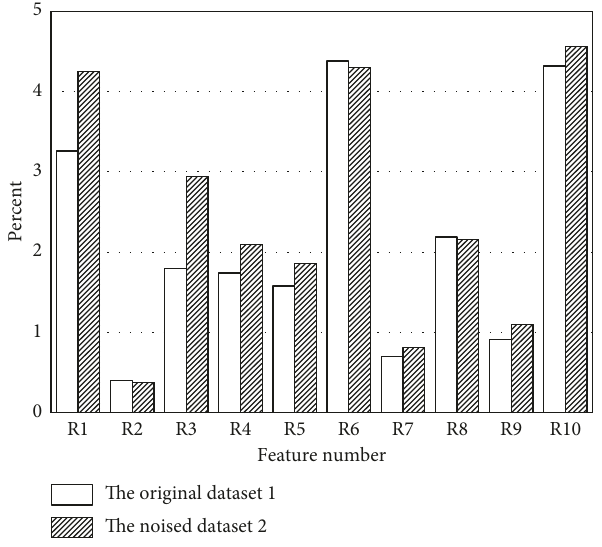
Figure 11: The proportions of RQA